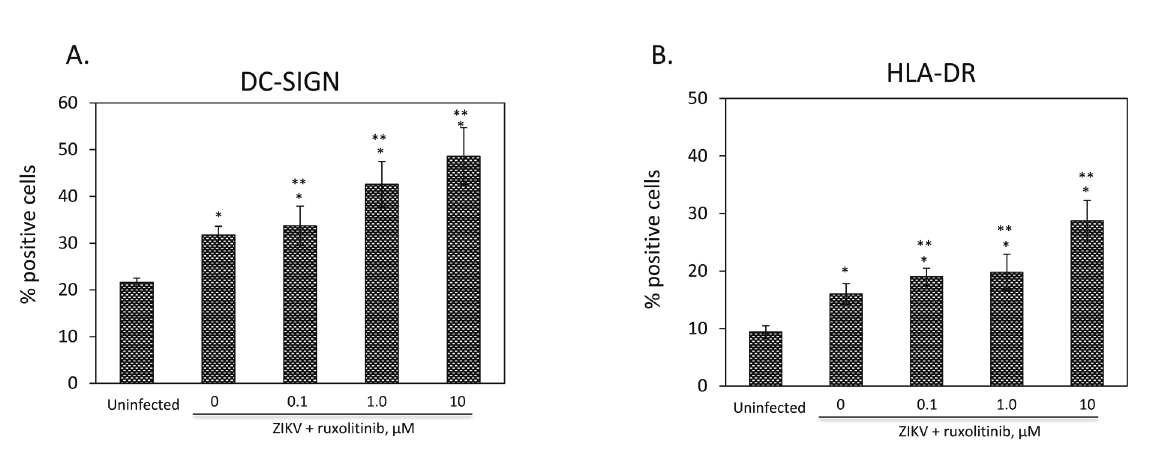
Figure 2. Effect of ZIKV infection alone or in the presence of Jak1/2 blockade PRVABC59 on activation markers in primary human hofbauer cells. ZIKV (MOI 1) significantly increased (* P < 0.01 versus un- infected controls, one way ANOVA; ** P < 0.01 one way ANOVA versus no drug controls) DC-SIGN and HLA-DR (A and B,